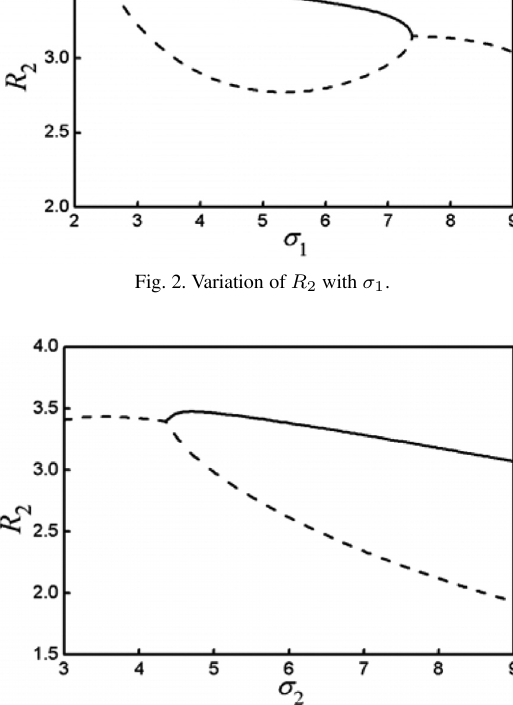
Fig. 3. Variation of R 1 with σ 2 . Fig. 4. Variation of R 2 with σ 2 .